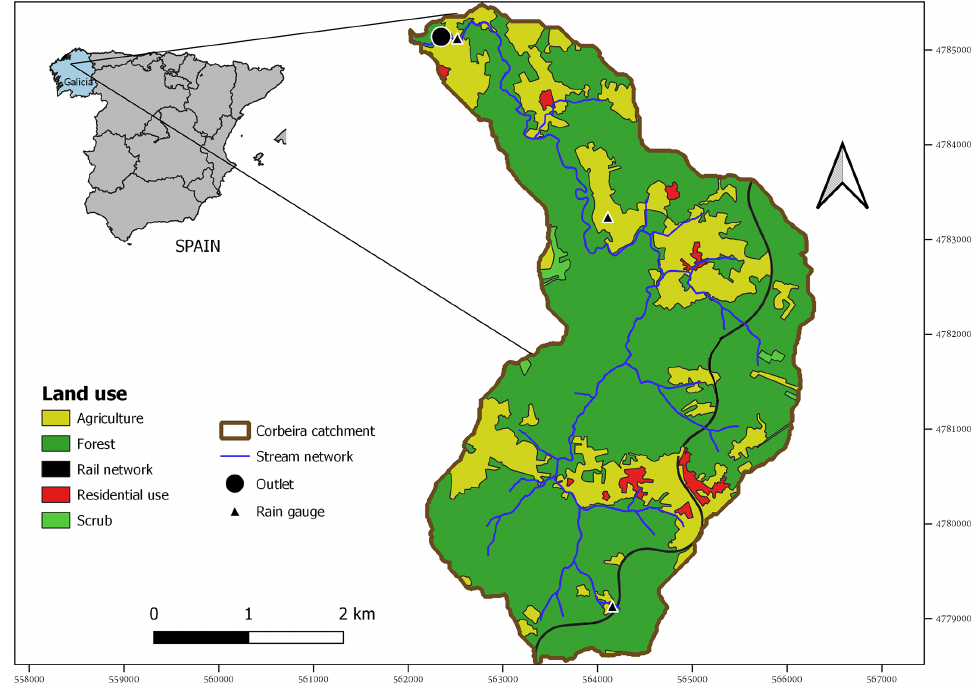
Figure 2. Location and land use of the Corbeira